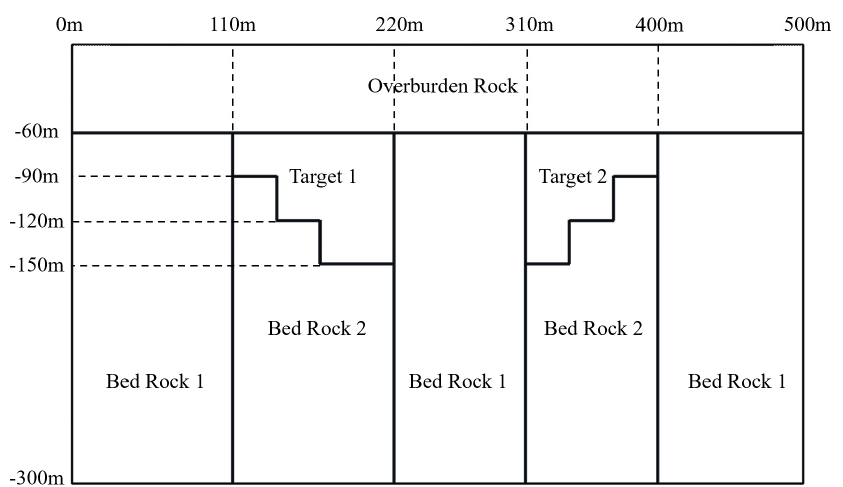
Figure 9. Schematic diagram of model 1.